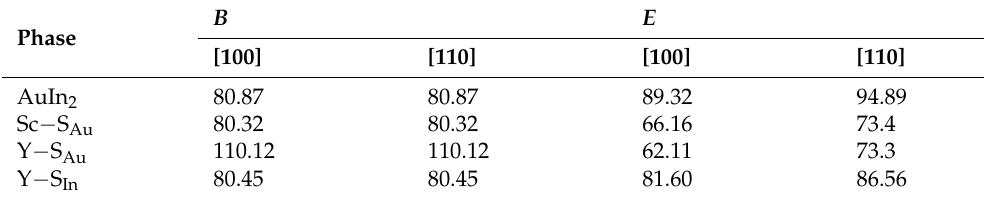
Figure 7. Projections of bulk and Young’s modulus of AuIn 2 and its doped systems on (001) the crystal plane constant B ( a ), constant E ( b ). Table 5. The bulk modulus and Young’s modulus of AuIn 2 and doped systems in [100] and [110] directions (GPa) are calculated.